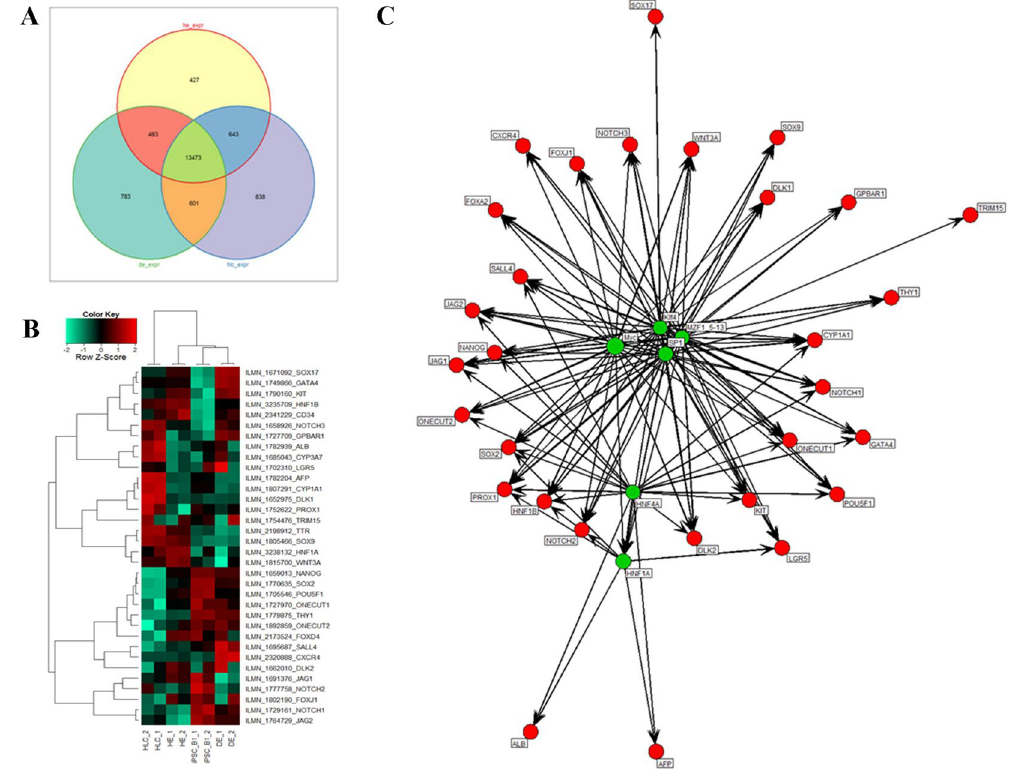
Figure 6. Cell fate decision. ( A ) Venn diagram of DE, HE and HLC. ( B ) Heatmap of bipotential progenitor- associated, hepatocyte-related and cholangiocyte-associated genes. ( C ) An induced network of transcription factors with a Z-score > 10 (green, size of circle corresponds to Z-score) and associated genes